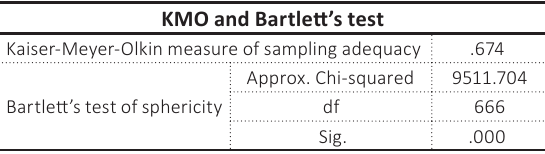
Table 2. KMO and Bartlett’s test